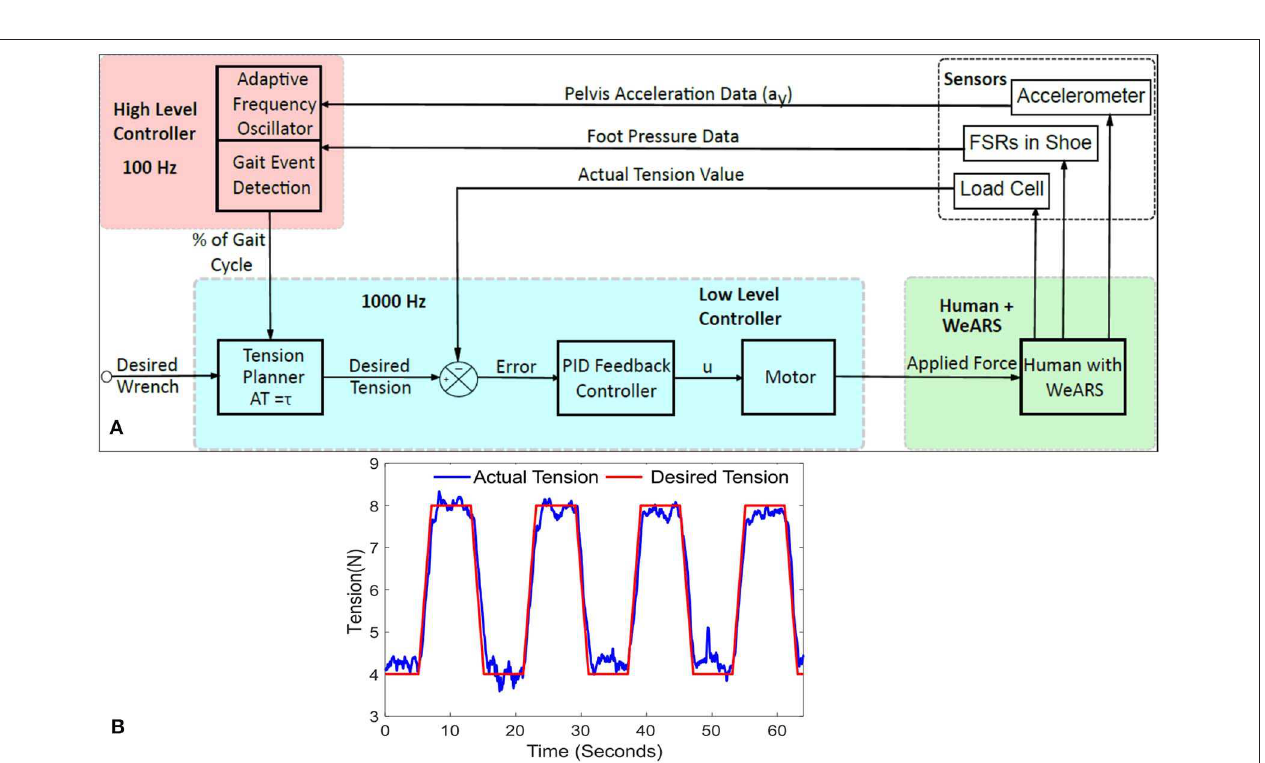
FIGURE 3 | (A) Control architecture: the high-level controller, at 100 Hz, provides the gait phase values in %age of the gait cycle and adapts human walking using adaptive frequency oscillators and gait events. A low-level controller, at 1,000 Hz, plans the cable tension values based on desired force intervention, wrench, and uses a PID feedback control to implement the cable tension values. (B) PID performance response while controlling a desired cable tension value.